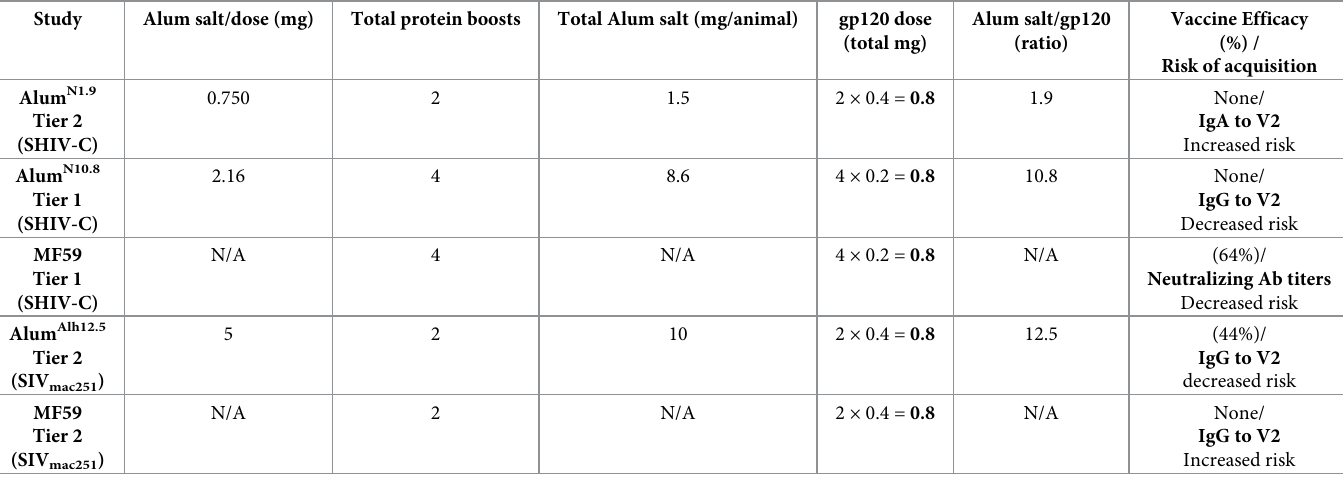
Table 1. Adjuvant and gp120 envelope protein dosage and correlates of risk of SHIV-C acquisition. Study Alum salt/dose